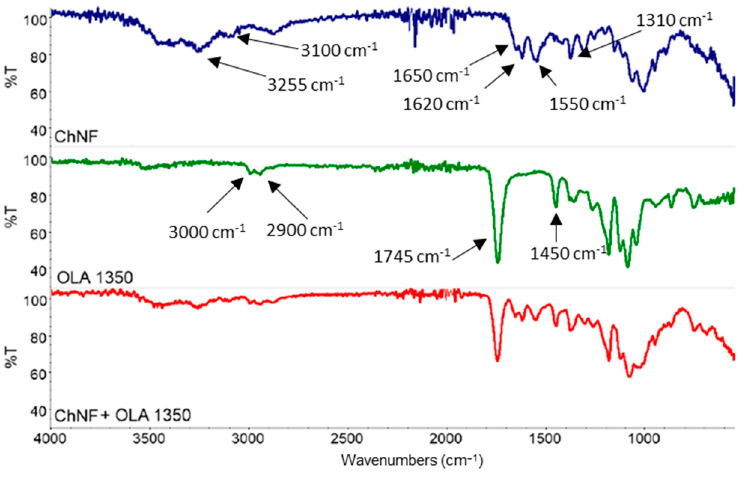
Figure 4. FTIR spectra of CN (shrimps) + OLA 1350 dispersion and single components.